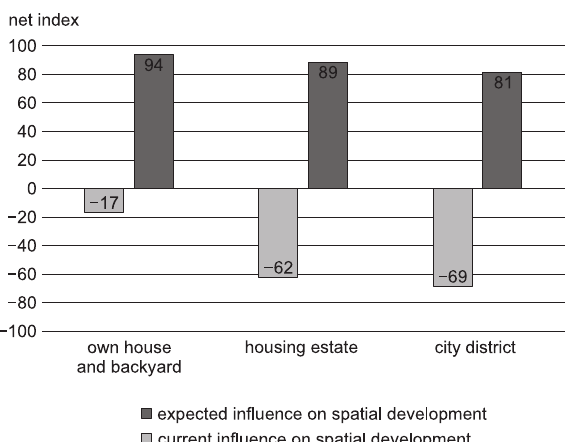
Fig. 3. Inhabitants’ opinions regarding their current and expected influence on spatial development – net